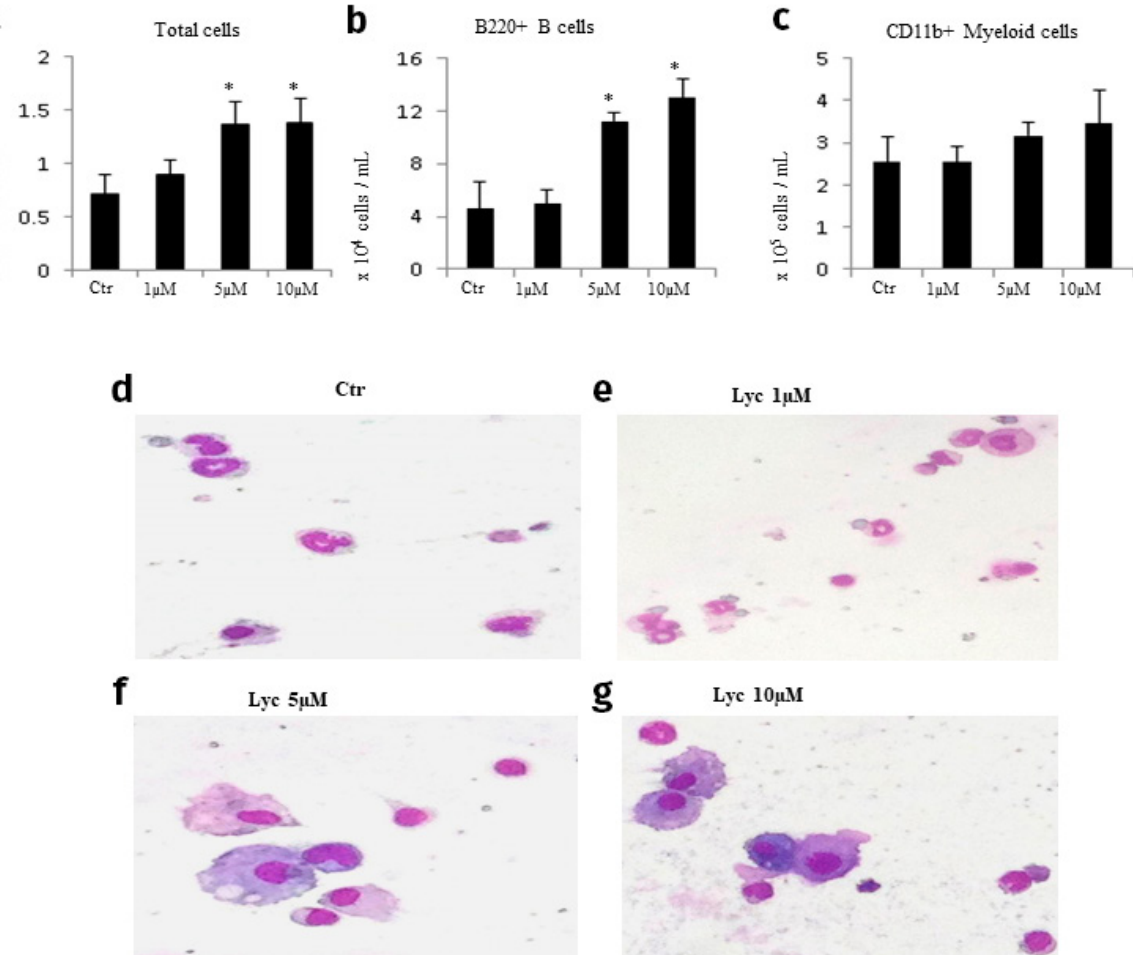
Figure 1. Definition of lycopene concentration to B cell differentiation analysis. (a) Cellularity of bone marrow cell culture. Number of B220 + B cells (b) and CD11b + cells (c) after lycopene supplementation. Morphological analysis of cultured cells at distinct conditions: (d) control, medium alone; (e) lycopene 1µM; (f) Lycopene 5µM and (g) Lycopene 10µM. Magnification: 1000x. n = 5 mice/group. (*) Indicates p